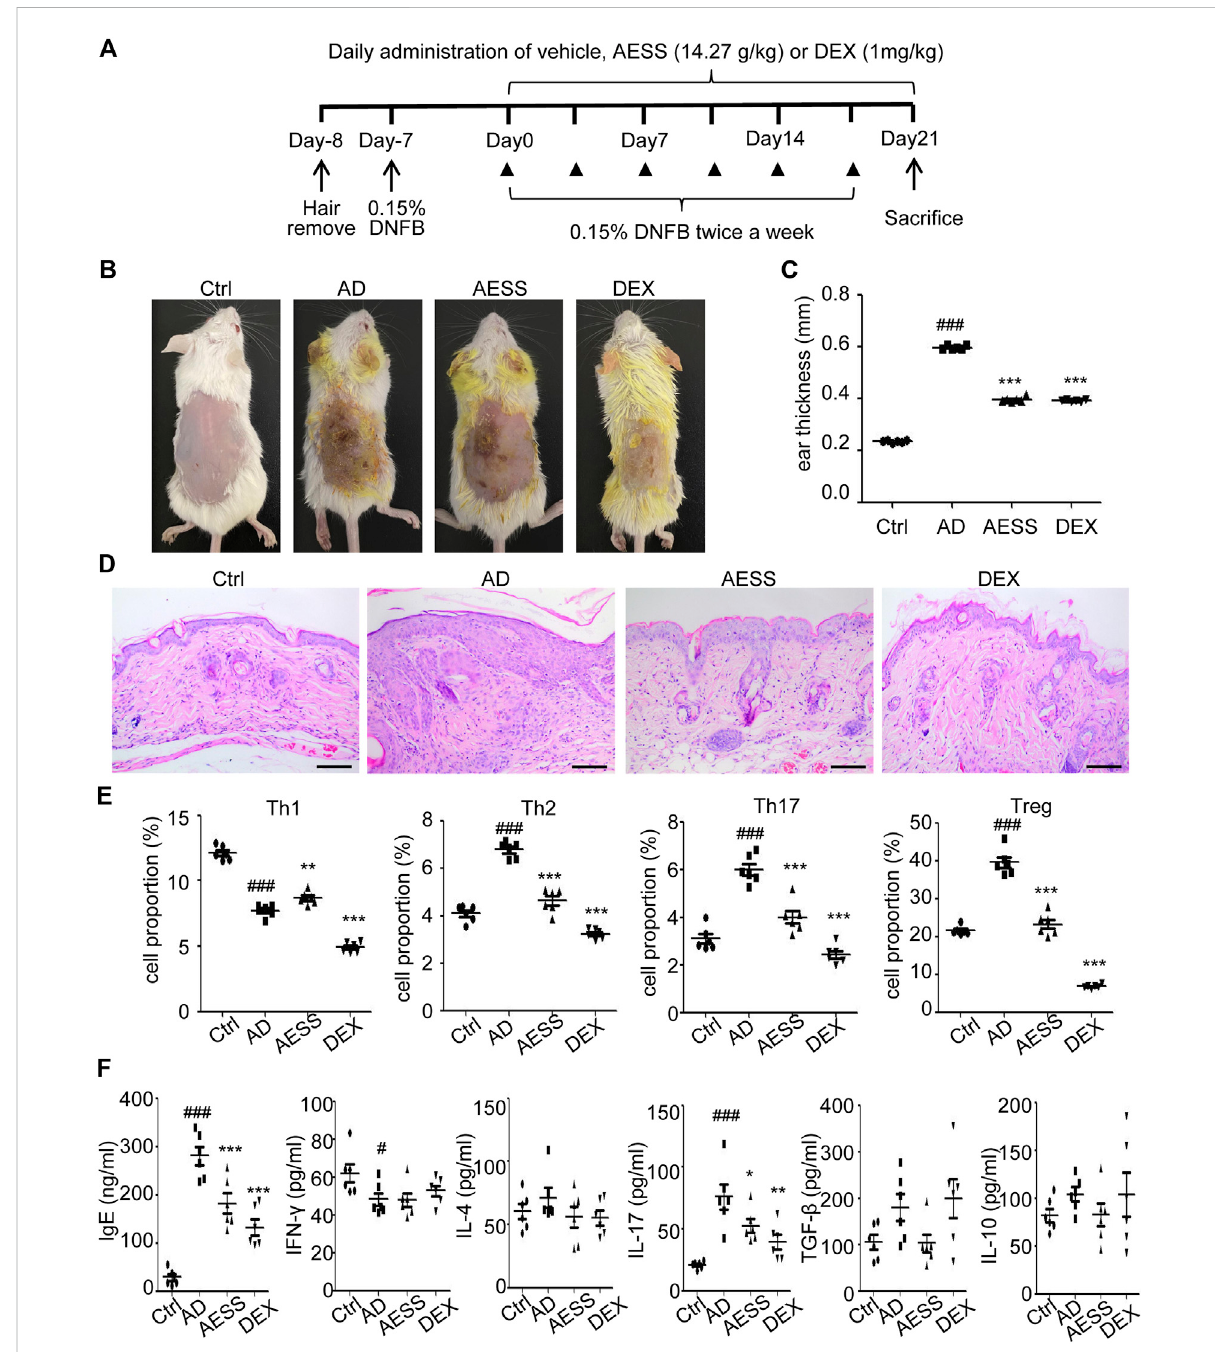
FIGURE 3 AESS formula could relieve skin lesions and regulate Th1/Th2/Th17/Treg balances of AD mice model (A) Experimental scheme for the DNFB- induced AD model. (B) General pictures of the mice. (C) Ear thickness of the mice (mm). (D) HE staining for histopathological features (bar length = 100 μ m). (E) The proportion of Th1/Th2/Th17/Treg cells in the peripheral blood of mice was determined using FACS analysis. (F) Levels of IgE, IFN- γ , IL-4, IL-17A, TGF- β and IL-10 in the peripheral blood of mice. ELISA for three replicates. Number of animals = 6. Ctrl: Control mice; AD: Atopic dermatitis model mice; AESS: Mice intragastrically administered of 14.27 g/kg AESS formula; DEX: Mice intragastrically administered of 1 mg/kg dexamethasone. # p < 0.05, ## p < 0.01, ### p < 0.001 v. s. Ctrl; * p < 0.05, ** p < 0.01, *** p < 0.001 v. s.